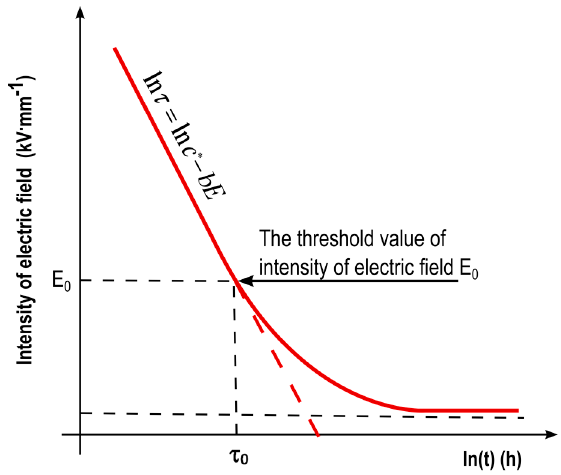
Figure 2. Exponential function of electrical aging plotted in semi-logarithmic scale (Redraw and adapted figure from [35]).